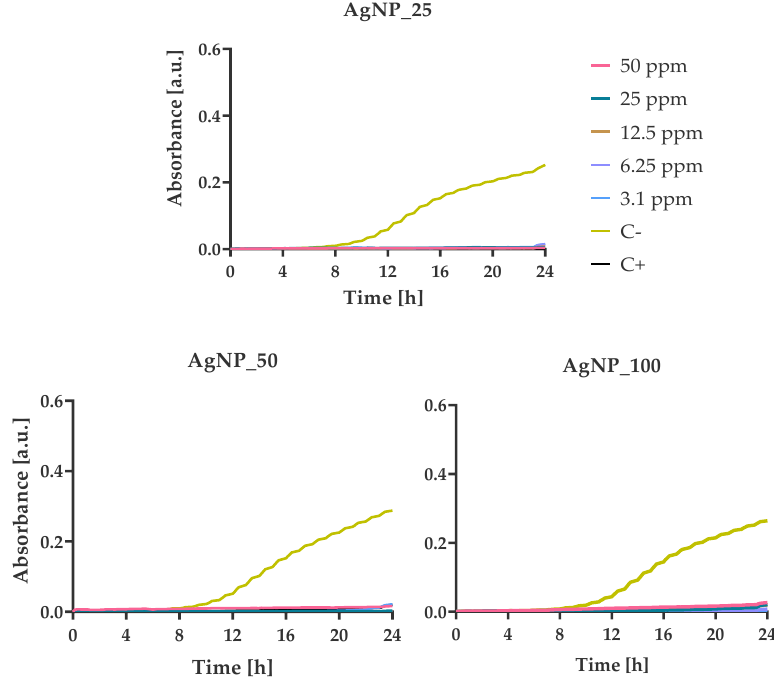
Figure 9. Growth kinetics of S. epidermidis in the presence of different concentrations (from 3.125 to 50 ppm) of AgNPs. Optical density was measured for 24 h at 37 ◦ C using a multi-detection microplate reader at 600 nm and automatically recorded for each well every 15 min. In all experiments, the bacterial suspension in pure MH-B and in the presence of amoxicillin/clavulanic acid (50 ppm) were the negative and positive control, respectively.